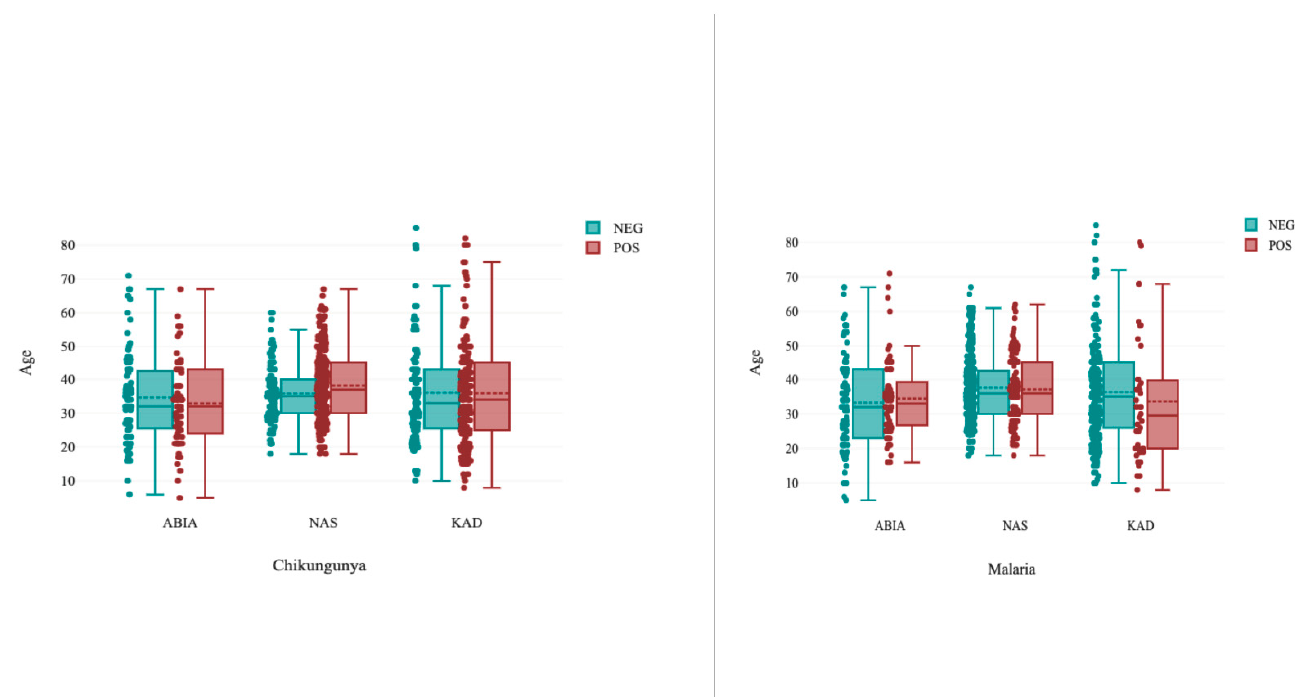
Figure 2. Boxplot of the median age of infected and noninfected persons with chikungunya and malaria in three regions of Nigeria. Age specific seroprevalence of chikungunya and malaria in the three regions. Abia (ABIA; Southern region); Nasarawa (NAS: Central region); Kaduna (KAD; Northen region).